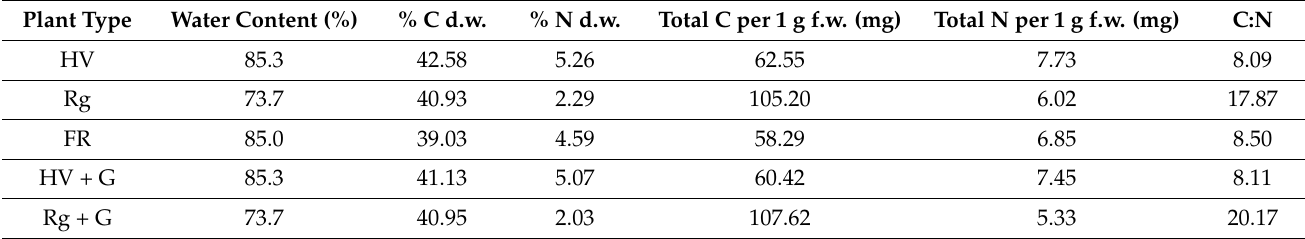
Table 1. Mean properties of the plant residue added to the incubation columns. Plant